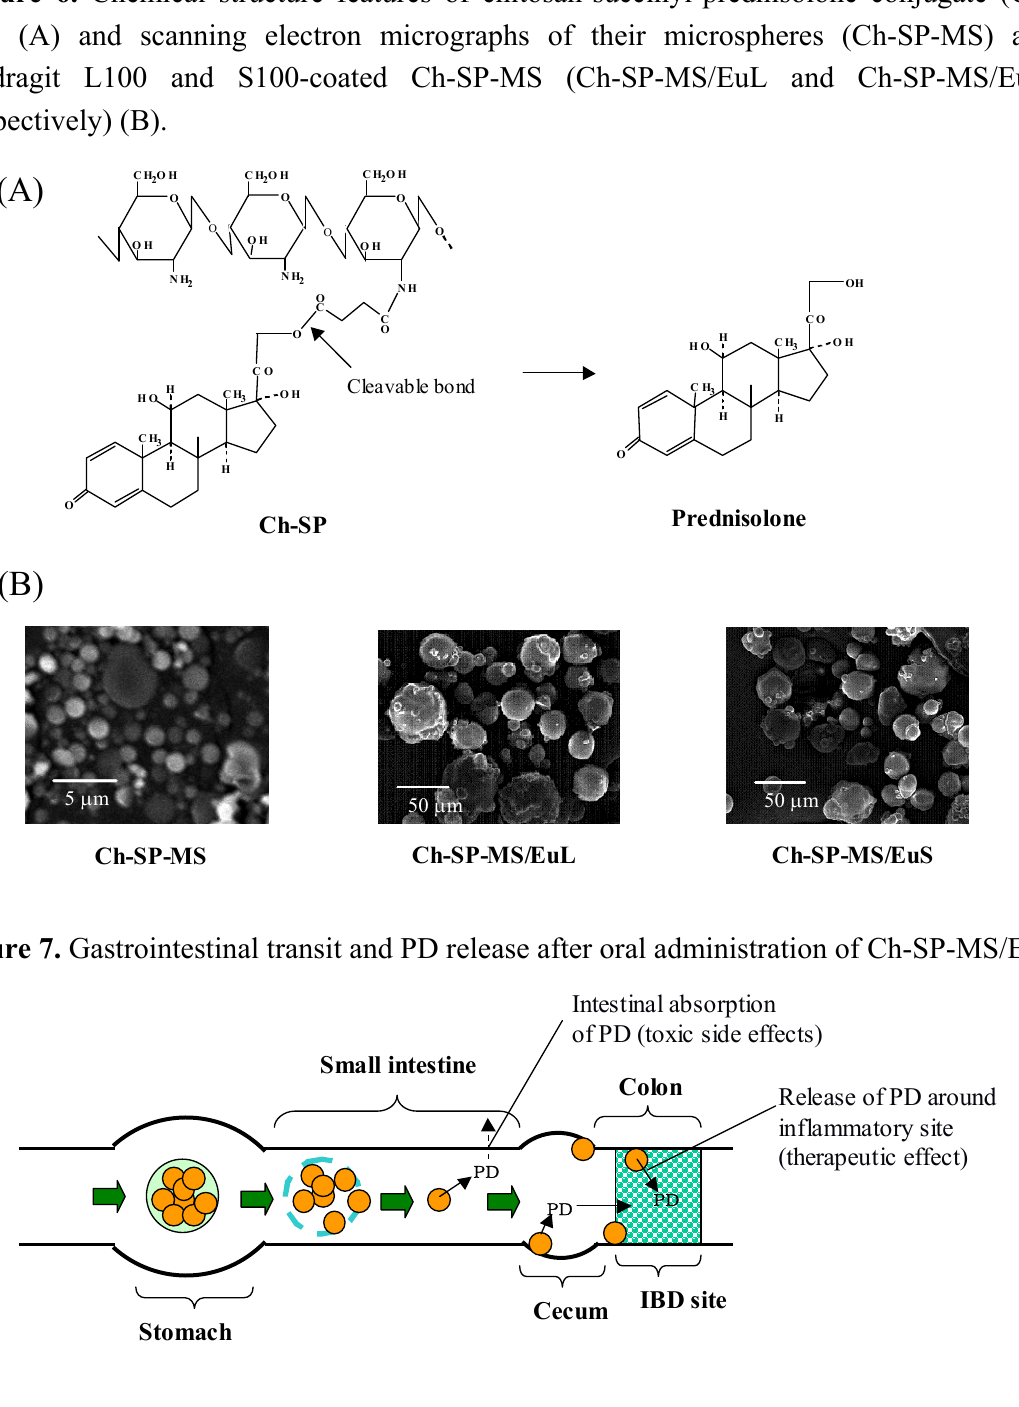
Ch-SP-MS swelled extensively and collapsed at stomach pH (pH 1.2). Therefore, they were enteric- coated in order to avoid such swelling or collapse in the stomach [79]. Eudragit L100- and S100- coated Ch-SP-MS, named Ch-SP-MS/EuL and Ch-SP-MS/EuS, respectively (Figure 6), protected Ch- SP-MS from swelling and collapsing at stomach pH, and released Ch-SP-MS at intestinal pH. The release of PD was suppressed at pH 1.2, but increased at pH 6.8 and 7.4. These properties were suitable for the specific delivery of Ch-SP-MS to the lower intestine and specific release of PD. Ch- SP-MS/EuL and Ch-SP-MS/EuS were suggested to be useful as a specific drug delivery system to IBD sites as shown in Figure